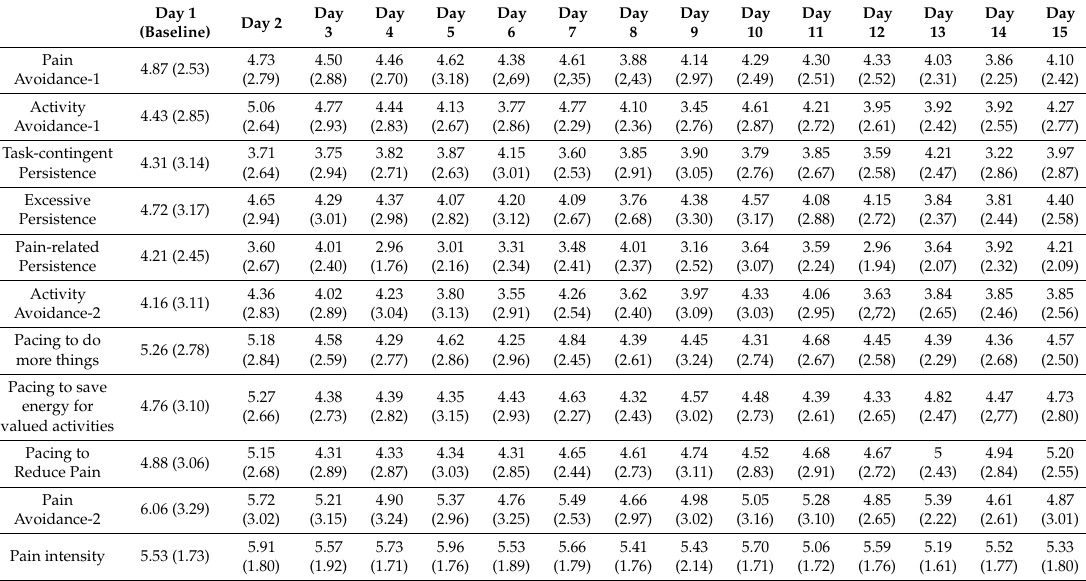
Table 1. Patterns of activity per day. Means and standard